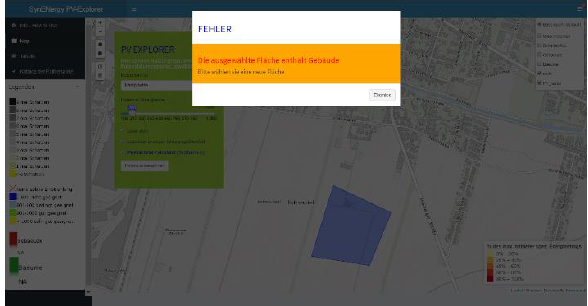
Figure 3. PV-Potential Calculator-User Guide (incorrect usage) © AIT 2018